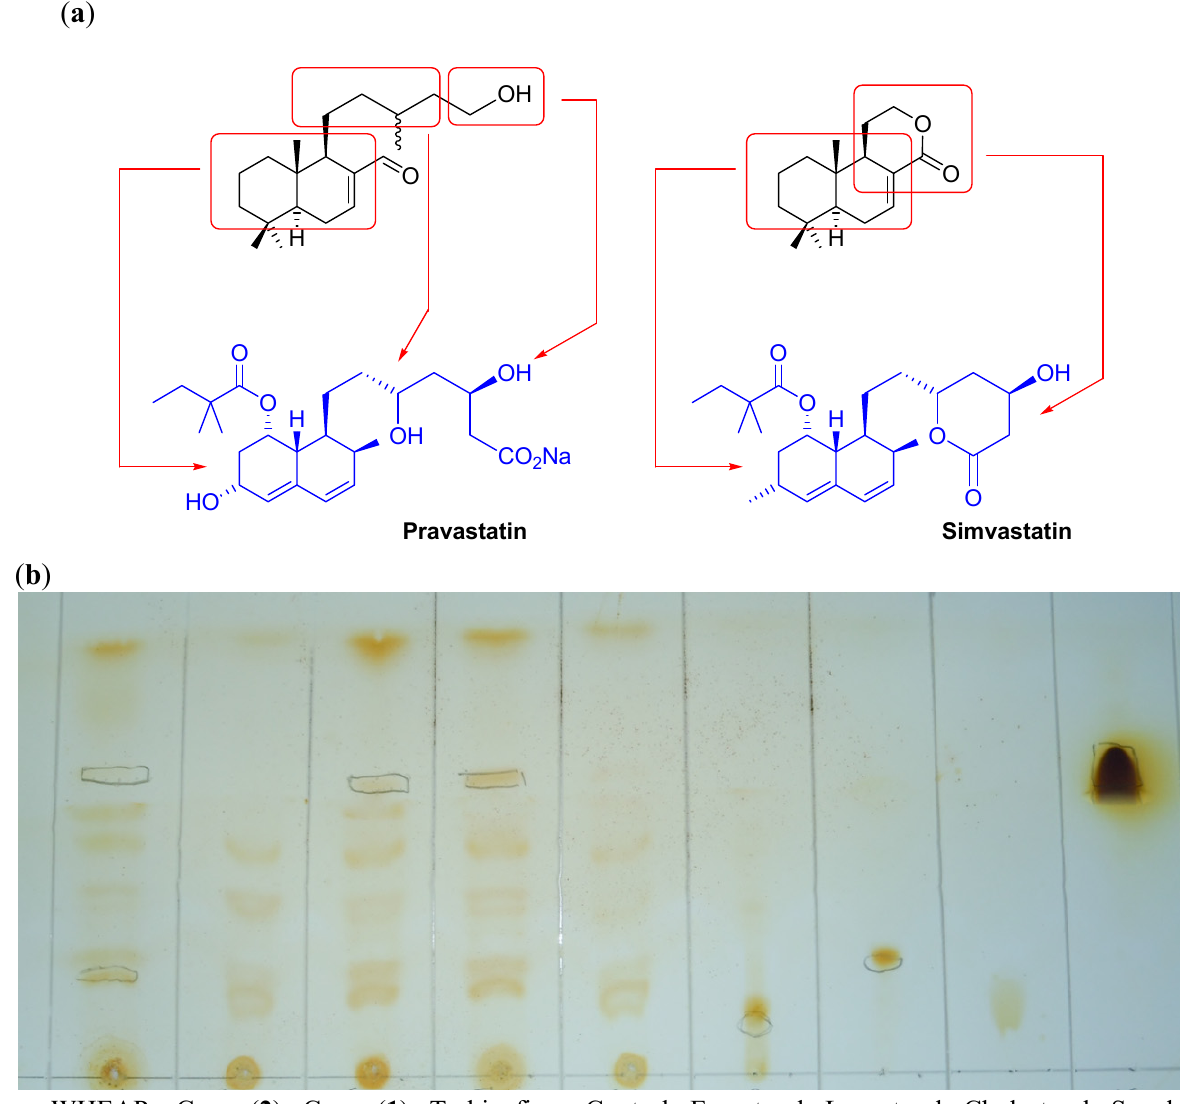
Figure 7. ( a ) Structure of some statins, i.e. , pravastatin and simvastatin, structurally related to compounds 1 and 2 . ( b ) Examples of TLCs of the study of changes in the membrane sterols. Control means untreated parasite. Terbinafine was used as control of T. cruzi squalene